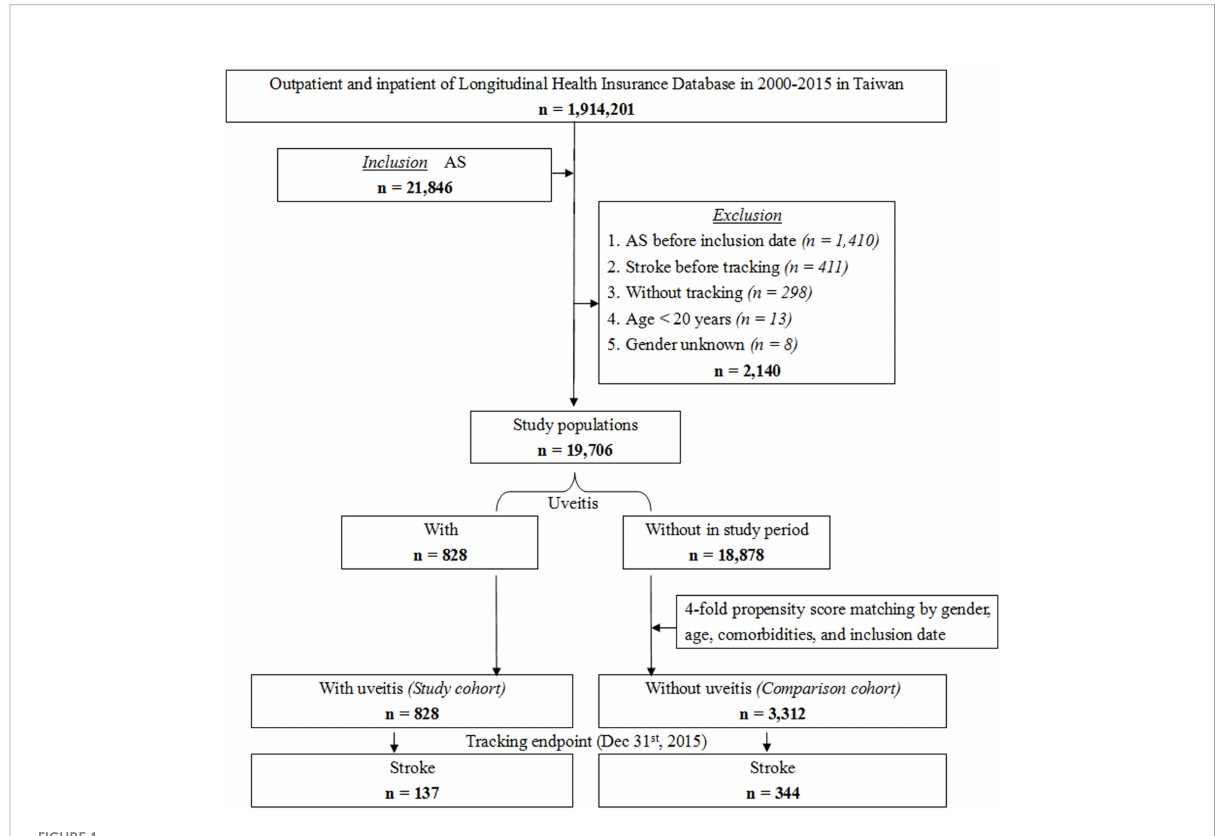
FIGURE 1 Flowchart of the